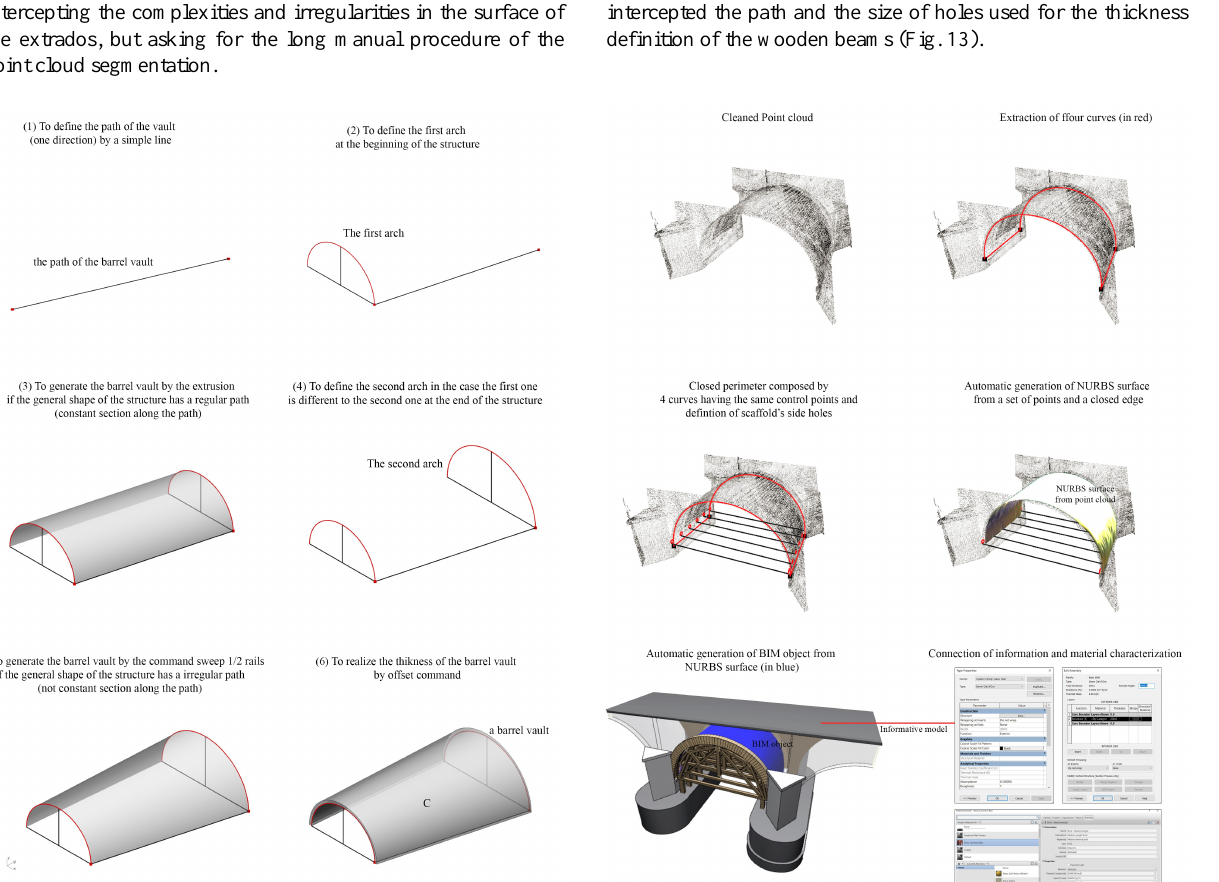
Figure 12. The traditional process: ‘how to model a barrel vault’. The traditional process requires, in addition to the previous type of vaults, a great number of modelling tools. Each step is not oriented to intercept the real inner shape detected by laser scanning and digital photogrammetry.